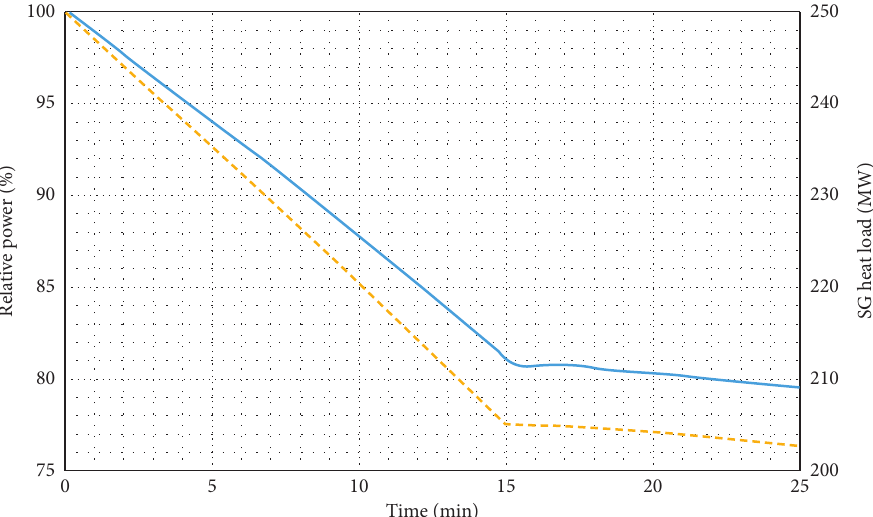
Figure 9: Relative power and SG heat load of #2 module in case 1 (solid line: relative power; dashed line: SG heat